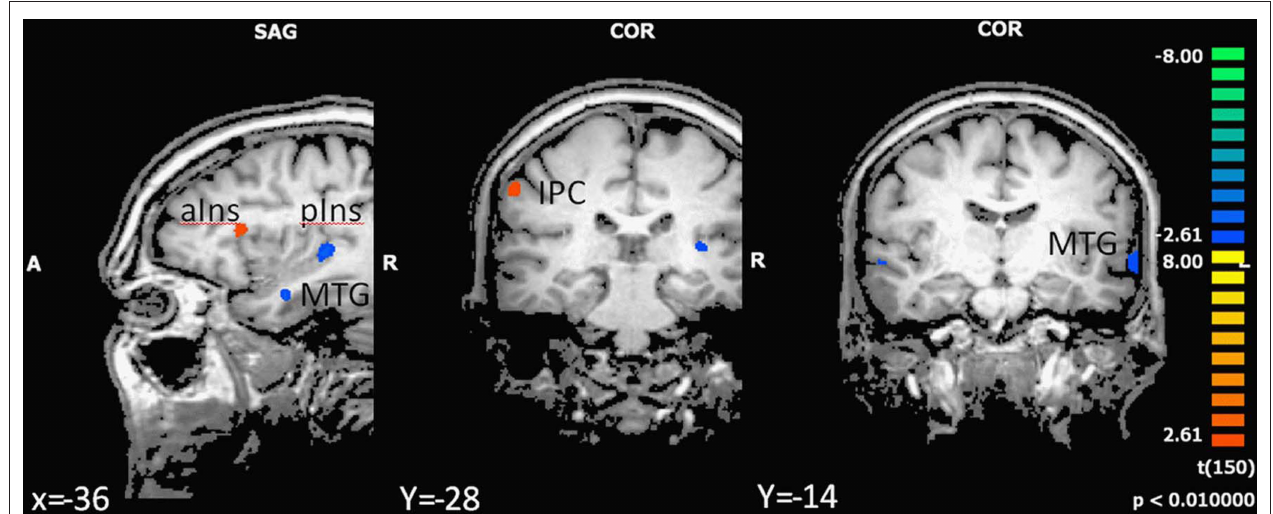
FIguRe 3 | effect of motor status on brain activation during imagery of forward walking. Regions with significant differences for high- and low-fit participants are shown in blue to green (low fit > high fit) and orange to yellow (high DLPFC, dorsolateral prefrontal cortex; aIns, anterior insula; pIns, posterior